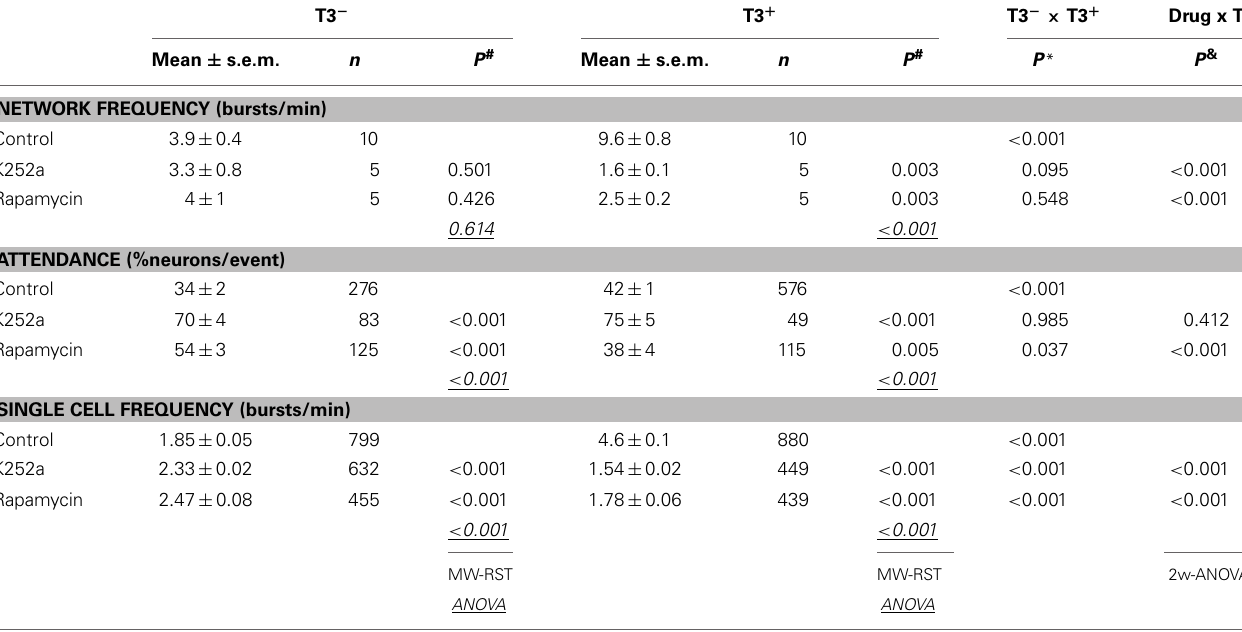
Table 4 | Summary and statistical analysis of spontaneous activity imaging recordings of 14 day-old networks and T3, K252a, and rapamycin effects. T3 − T3